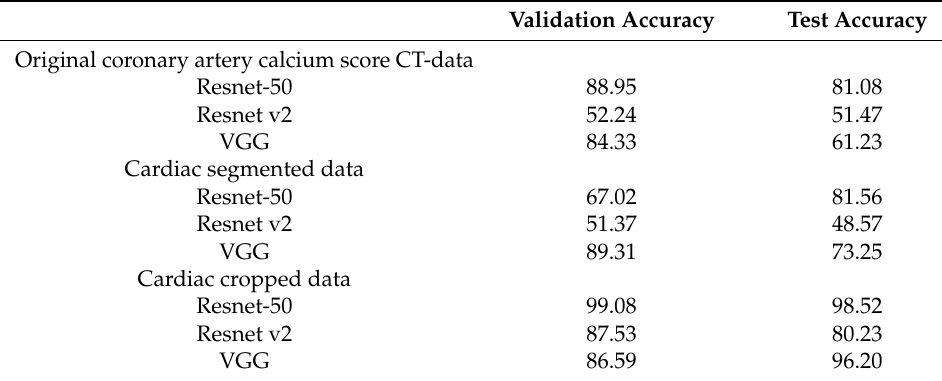
Table 3. Results of validation and test accuracy for each